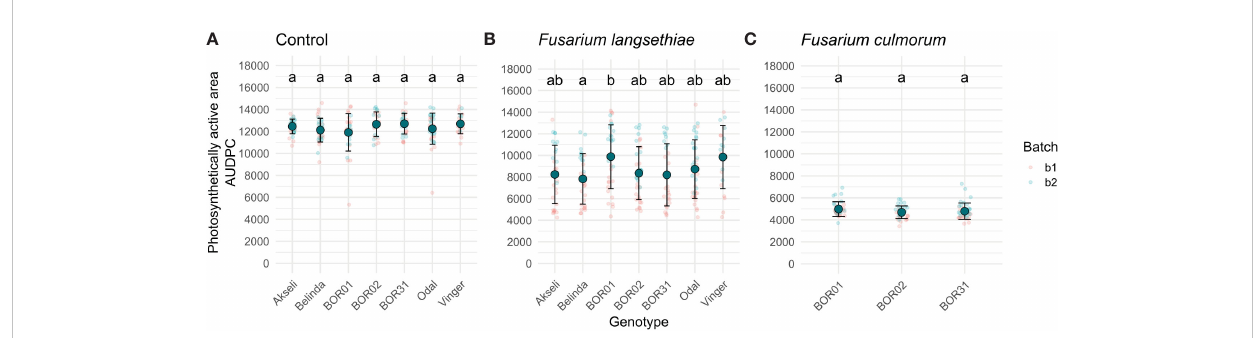
FIGURE 7 Area under disease progression curve (AUDPC) of spikelet photosynthetic area relative to its size at 0 hours post infection (HPI). Plots show data of the seven oat genotypes used in this study inoculated with (A) mock control, (B) F. langsethiae , or (C) F. culmorum . Small red dots correspond to data from batch 1 (b1) and small blue dots correspond to data from batch 2 (b2). Big teal dots represent AUDPC mean, and error bars represent standard deviation. Groups sharing the same letter have no statistical differences at p < 0.05 assessed by Tukey HSD post hoc test. This analysis includes combined data from two experimental batches. Each data point represents the mean of 21 – 38 spikelets.